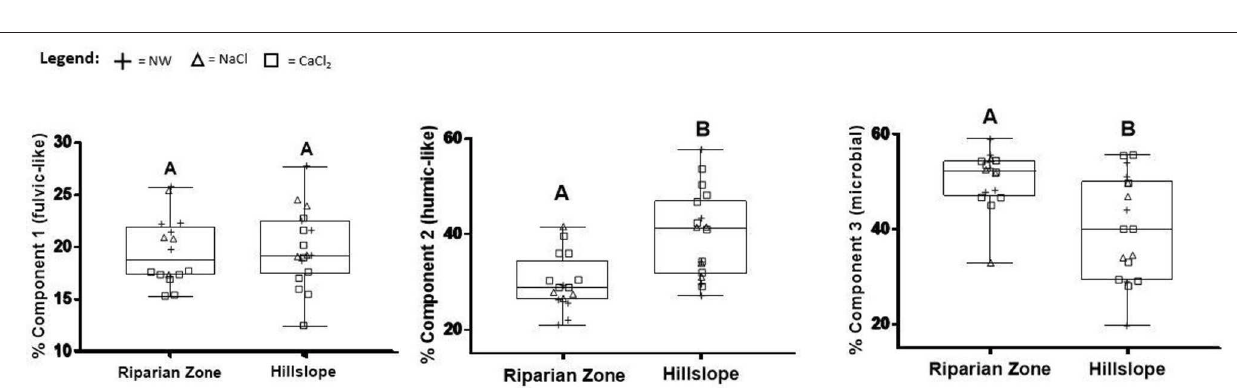
FIGURE 10 | Spectral Indices: Fluorescence Index (FI) (A,B) and Humification Index (HIX) (C,D) by extraction solution (NW, Nanopure water; NaCl, sodium chloride; CaCl 2 , calcium chloride) and landscape position.